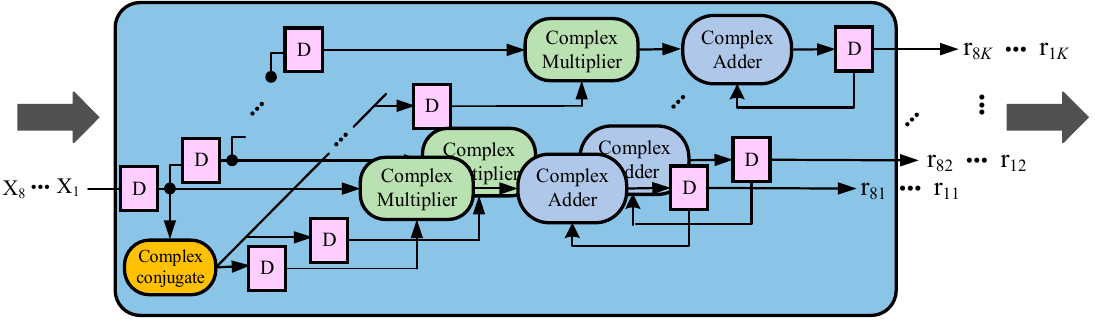
Figure 13. Systolic array design of the AM module.